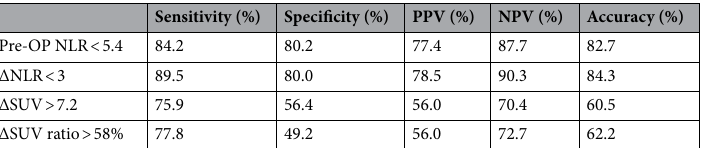
Table 3. Predictive efficacy of inflammatory factors and tumor glucose metabolism for pCR. PPV positive predict value, NPV negative predict value, pre-OP NLR neutrophil–lymphocyte ratio before operation,